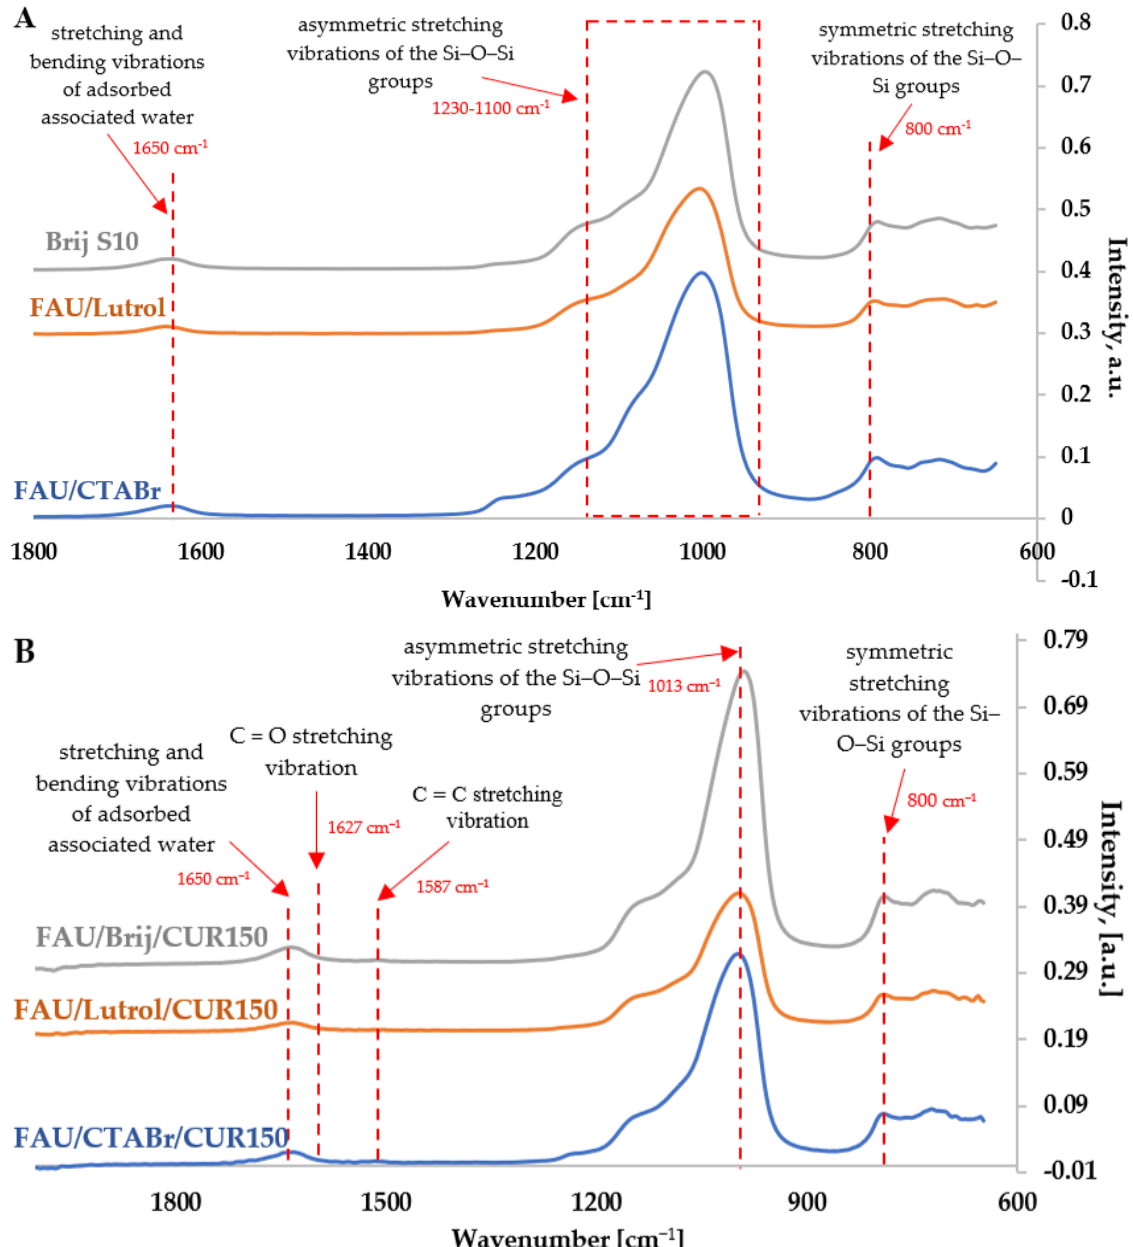
Figure 4. FT-IR spectra of hierarchical materials ( A ) based on FAU-type commercial zeolite and ( B ) those modified with